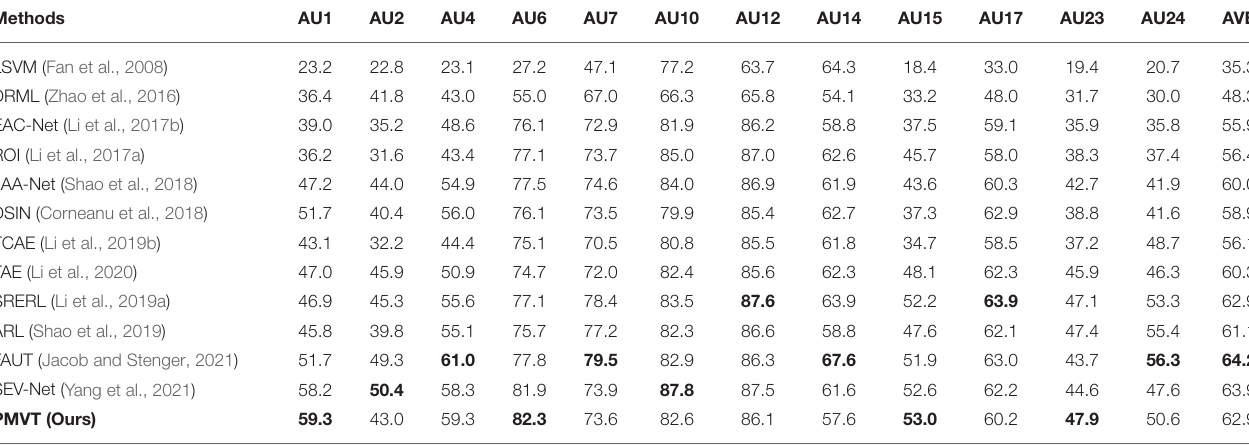
TABLE 2 | Action unit detection performance of our proposed PMVT and state-of-the-art methods on the DISFA dataset. Methods AU1